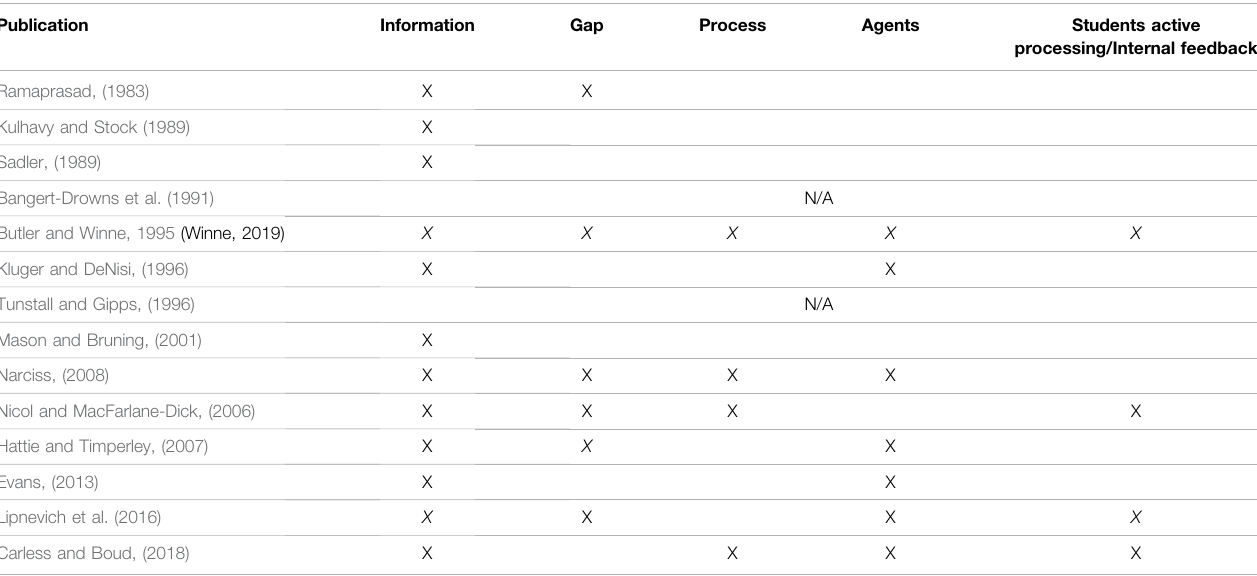
TABLE 4 | Elements of the de fi nitions of feedback used in the different